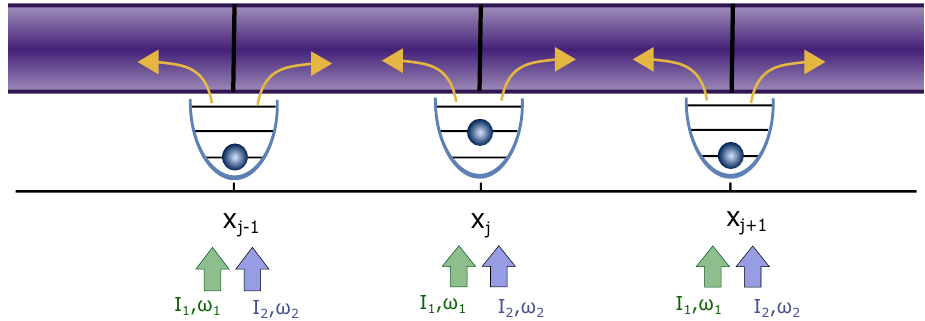
Figure 1. Sketch of our system: N particles are confined in homogeneous traps next to a nanofiber. The particles are illuminated by multi-color transverse pump fields and scatter light into the fiber. Interference of the scattered fields in the fiber leads to effective forces between the